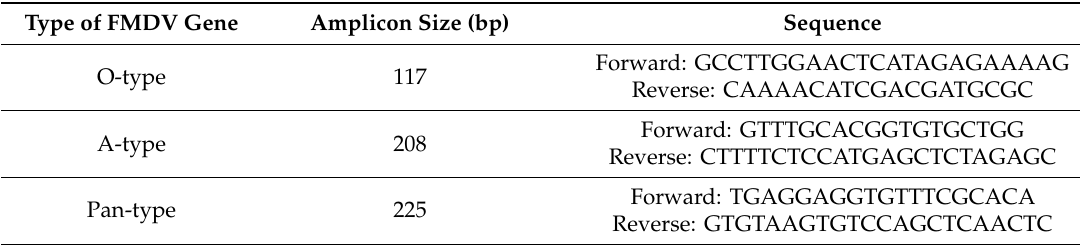
Table 1. Primer sequences used in this